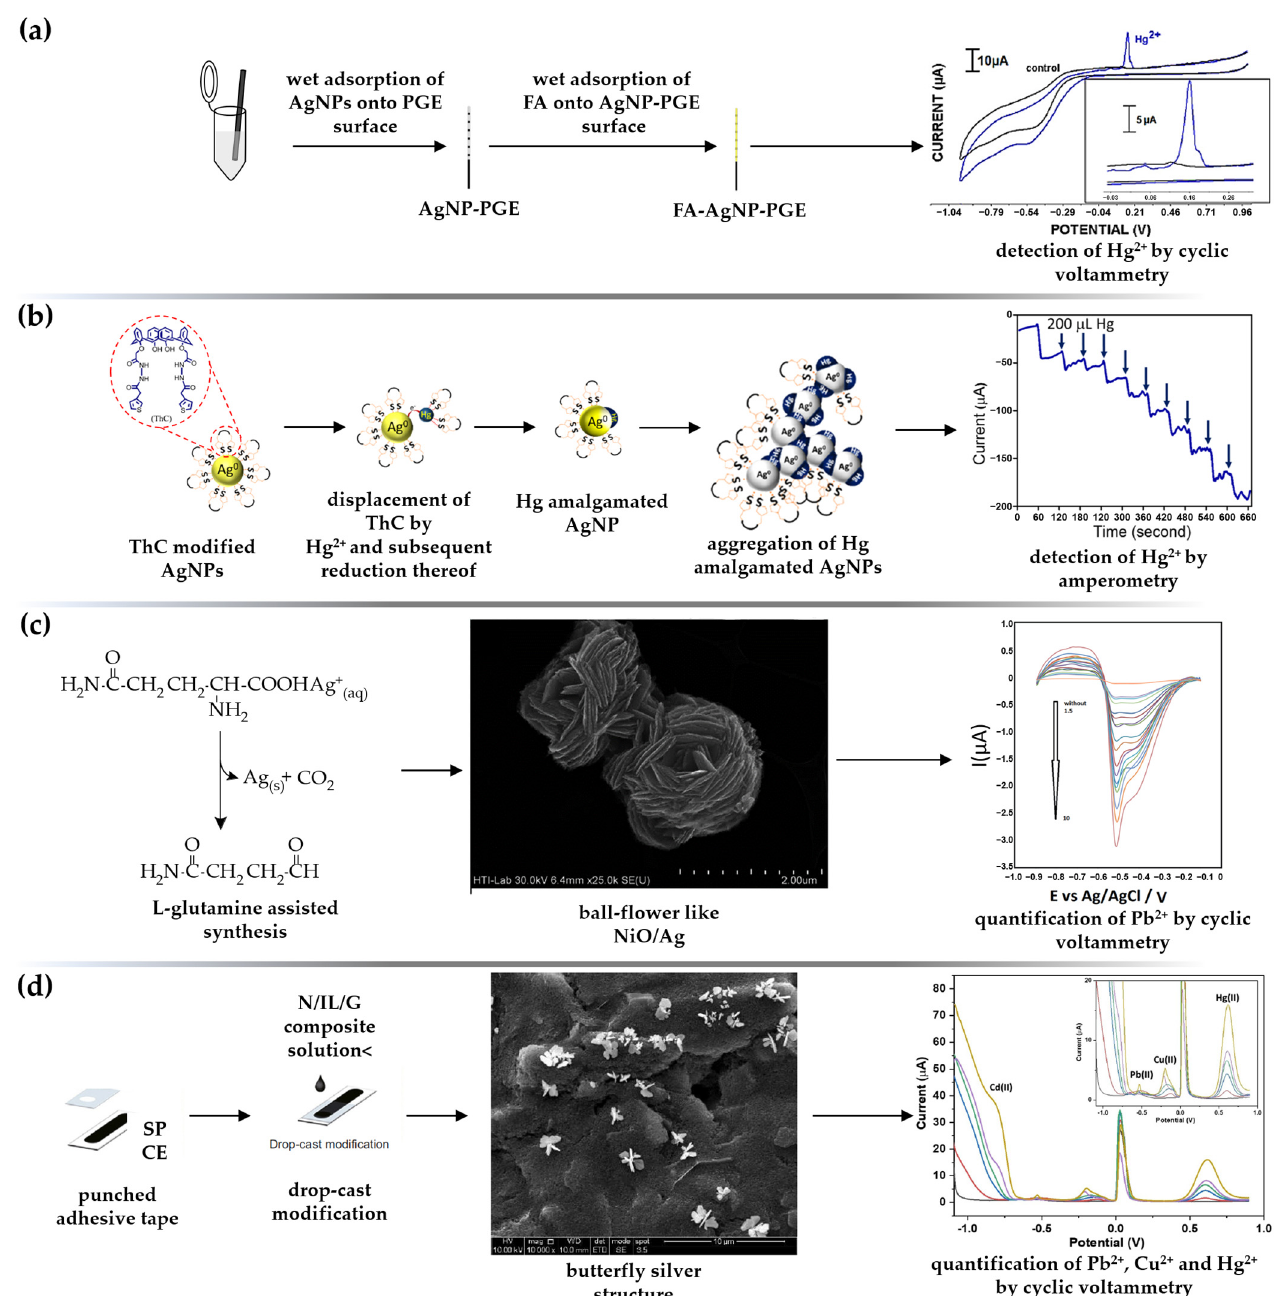
Figure 5. Illustration of AgNPs-based voltammetric and amperometric sensors for single and simultaneous detection of HMs in aquatic medium. ( a ) Fabrication steps of FA-AgNPs/PGE voltammetric sensor. In brief, PGE was firstly immersed in sodium citrate buffer solution of biosynthesized AgNPs and further immersed in folic acid (FA) solution for CV detection of Hg(II). Adapted from Ref. [97], copyright by John Wiley and Sons. ( b ) Amperometric sensor based on AgNPs displacement by divalent mercury. Adapted from [101] with permission. Copyright under ACS AuthorChoice License. ( c ) Pb(II)-selective DPV sensor based on ball-flower-like NiO/Ag/GCE sensing platform. Reproduced from Ref. [109], with permission from the Royal Society of Chemistry. ( d ) DPASV sensor based on SPCE decorated with butterfly-shaped silver nanostructure for the simultaneous detection of Cd(II), Pb(II), Cu(II), and Hg(II) in tap water and environmental (rain, lake, river) water, respectively. Reproduced from Naseri et al. [79] under the terms of Creative Commons CC BY license.